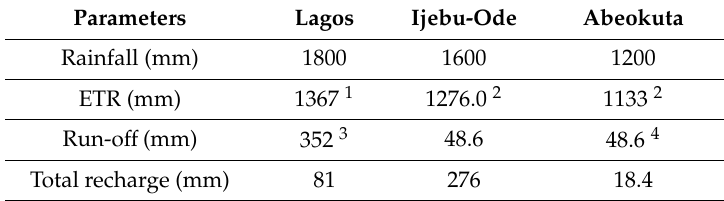
Table 3. Net recharges estimation from precipitation and runo ff (mm /